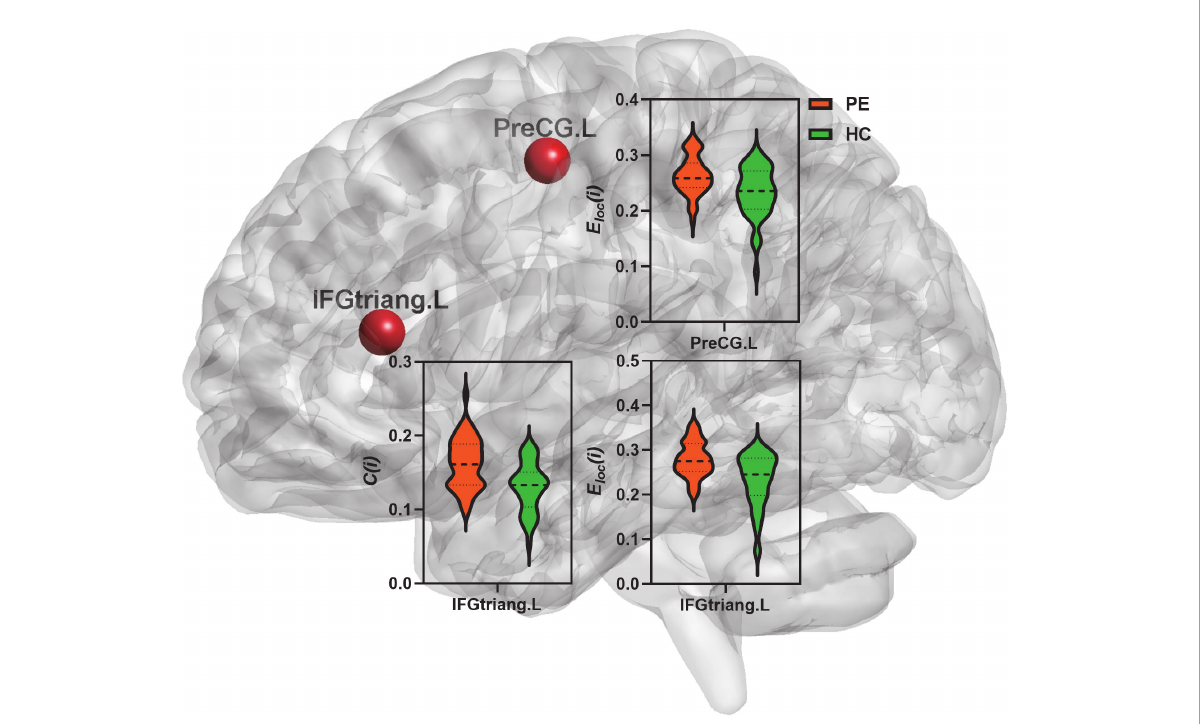
FIGURE2 Comparison of nodal segregative parameters between PE and HC groups. PE, premature ejaculation; HC, health controls. IFGtriang.L, left inferior frontal gyrus (triangular part); PreCG.L, left precental gyrus. C ( i ), the clustering coefficient of node i ; E loc ( i ), the local efficiency of node i . Comparison was performed using two-sample t -test. Bold and thin dashed line dotted lines in the violin plots represented the medians and quartiles of nodal segregative parameters; P < 0.05 indicated statistically significant differences.